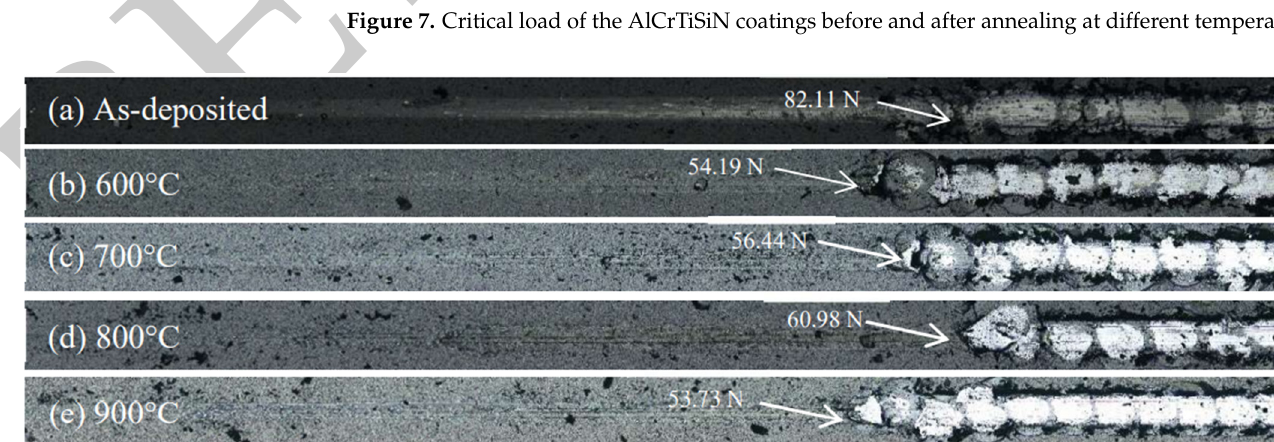
Figure 7. Critical load of the AlCrTiSiN coatings before and after annealing at different temperatures.